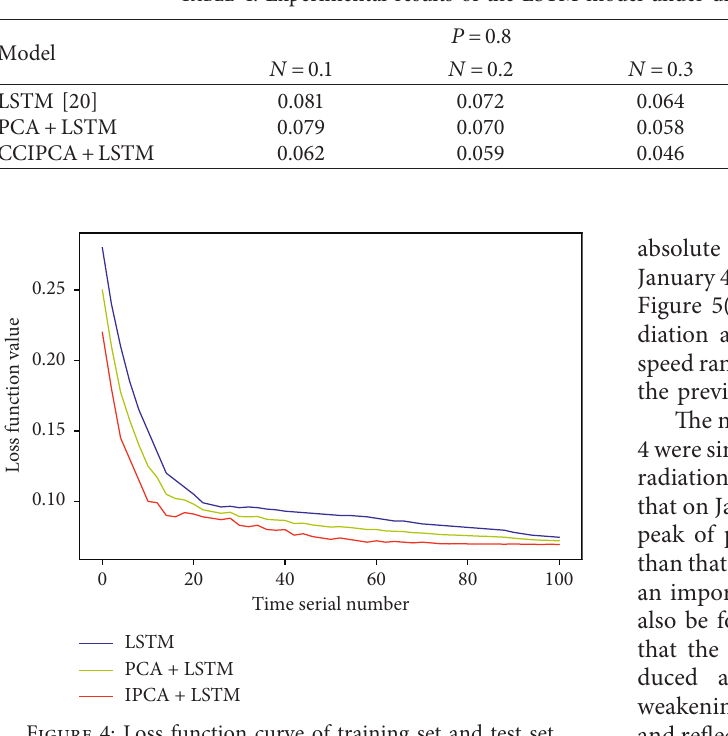
Table 4: Experimental results of the LSTM model under different parameters of optimization.